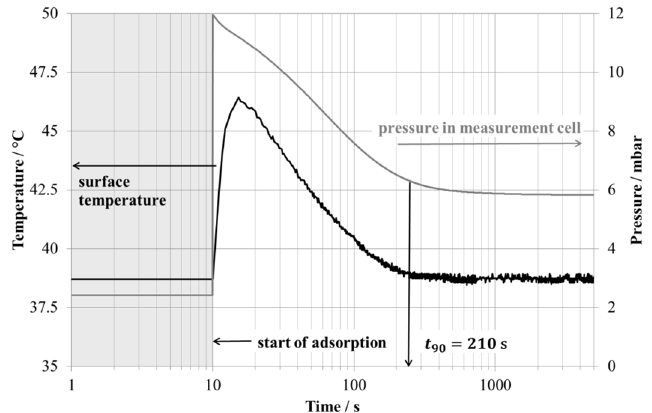
Figure 4. Surface temperature of sample and vapor pressure in measurement cell during water uptake as shown in Figure 3.